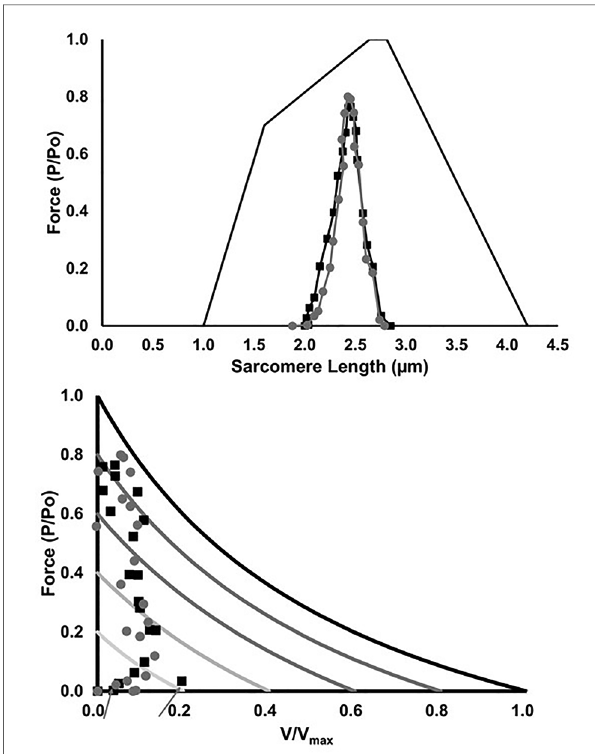
FIGURE 10 Muscle fascicle operating range on the force-length (top) and force- velocity relationship (bottom), respectively. Values are presented as mean±SD. Grey circles represent the SHORT AT MA group, while black squares represent the LONG AT MA group. The force-velocity relationship is scaled to level of muscle activation. Aarows show the higher shortening velocity in LONG during the fi rst 5% of the stance phase ( p =0.03) compared to